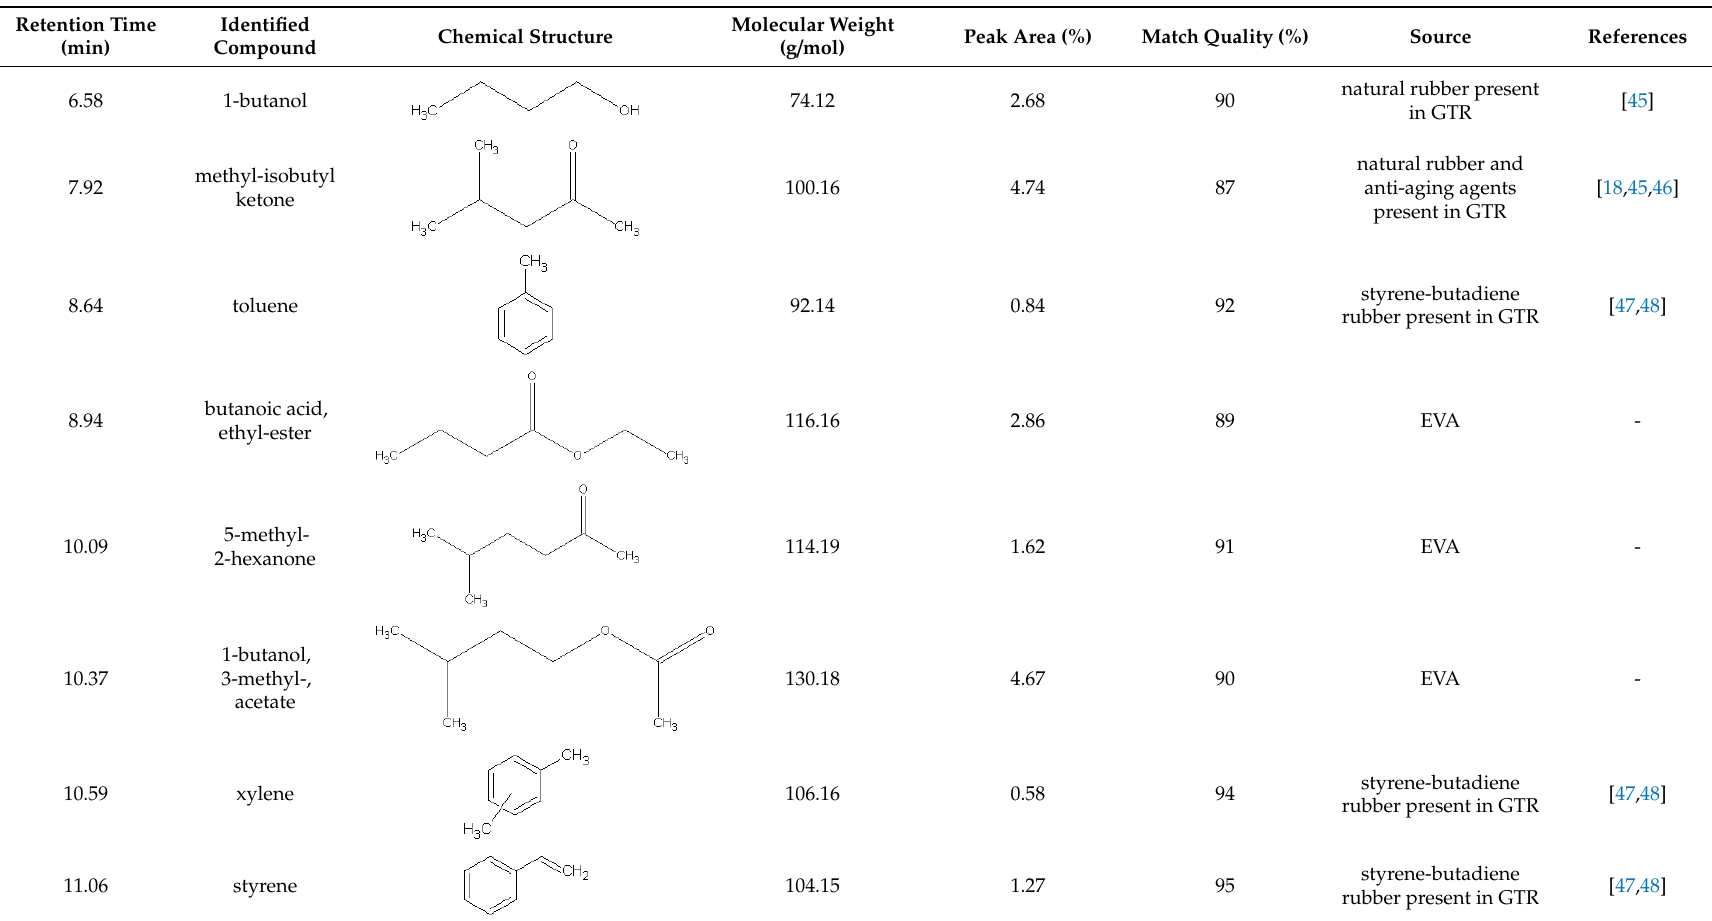
Table 10. Volatile organic compounds identified by gas chromatography with mass spectrometry (GC ‐ MS) measurement for GTR modified with ethylene ‐ vinyl copolymers.